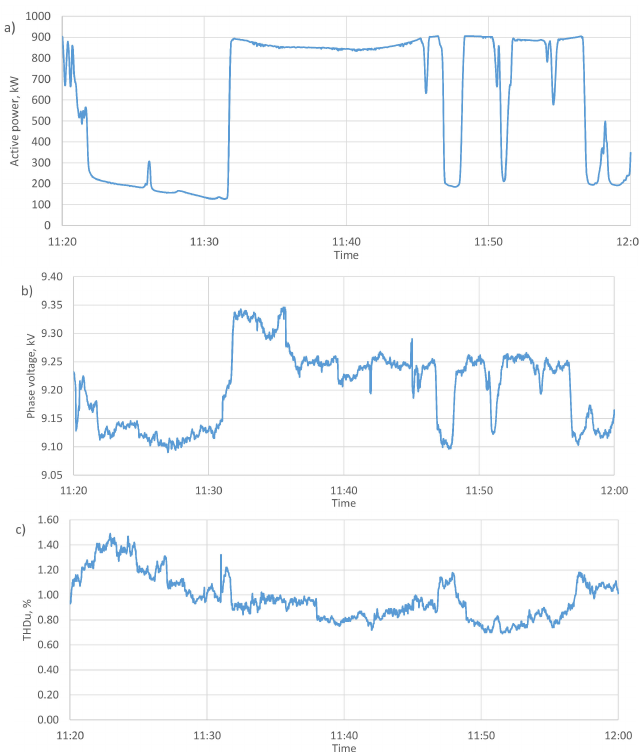
Figure 17. Exemplary one-hour waveforms for the photovoltaic power station: ( a ) active power, ( b ) phase voltage—RMS value; ( c ) voltage THD.